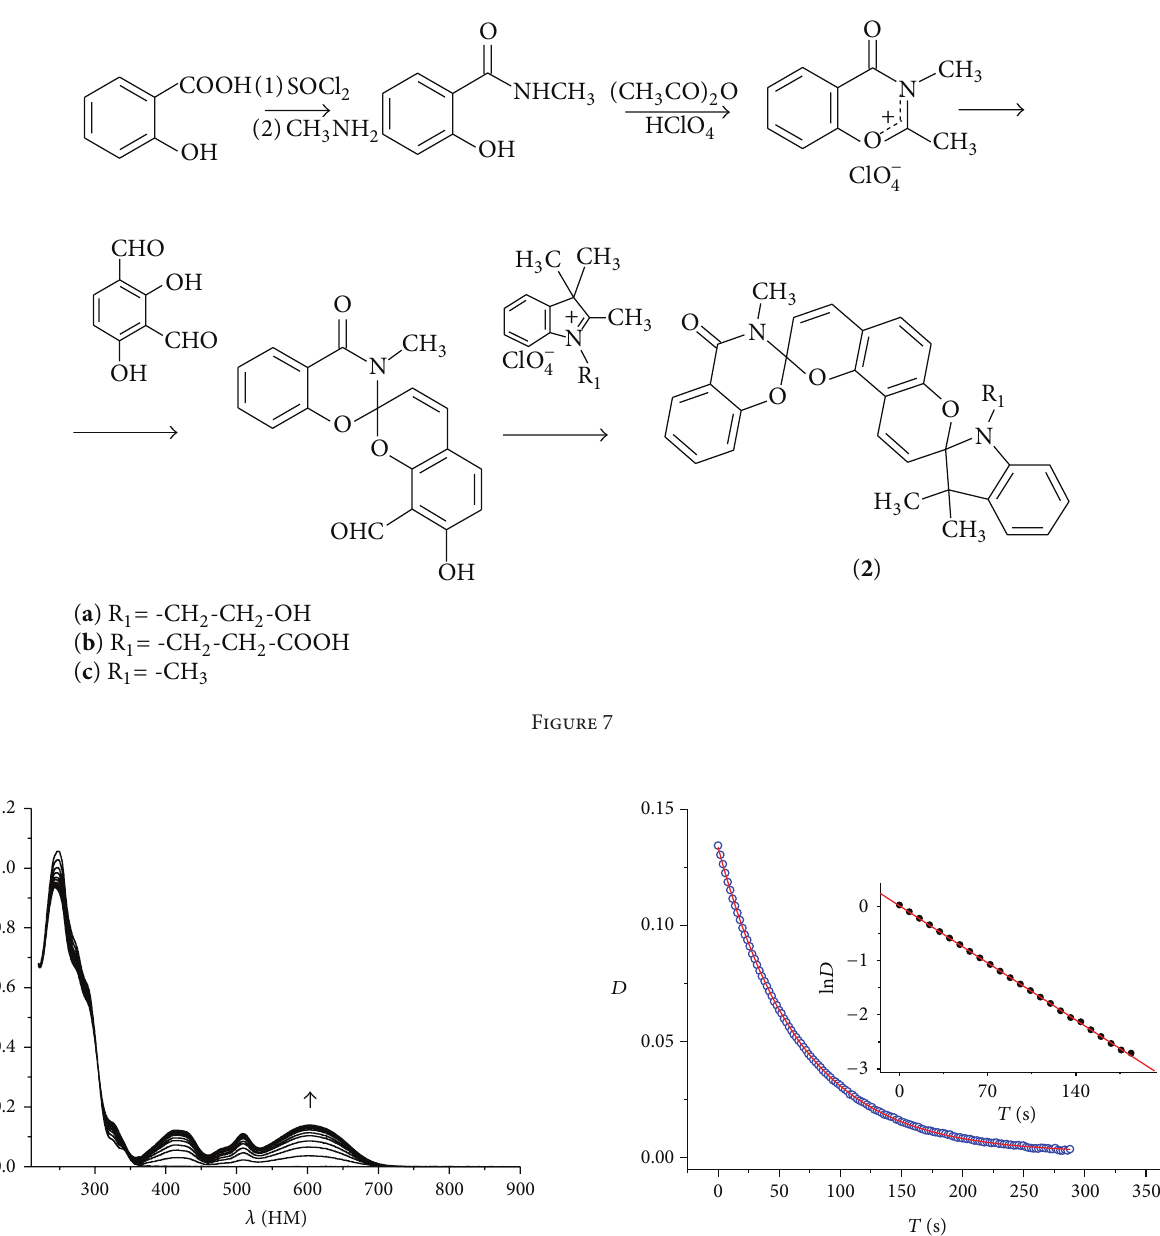
= 603 nm) of the thermal bleaching Figure 9: Kinetic curve ( 𝜆 obs reactionfor( 2a )( [ c ] = 3.19×10 −5 M, 𝑇 = 293 ∘ K)intoluenesolution and corresponding logarithmic